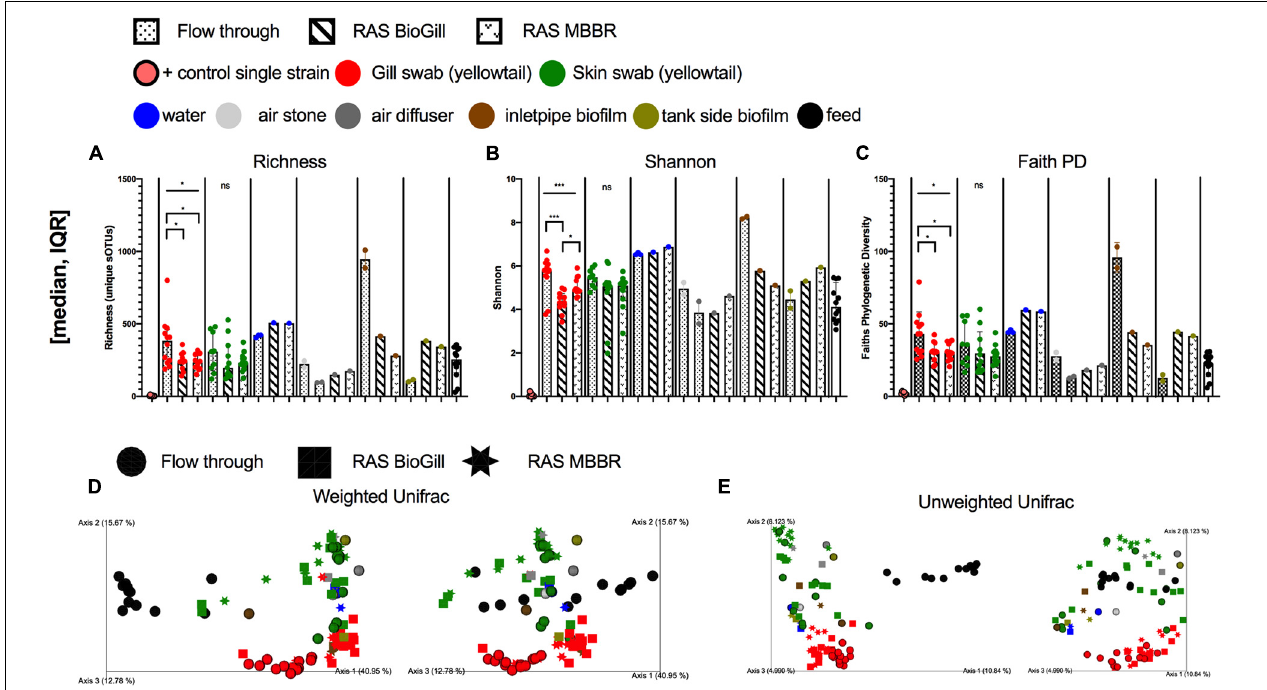
FIGURE 1 | Microbial diversity of the hatchery built environment along with fish gill and skin mucus at 130 days post hatch across three rearing tanks (flow through, RAS BioGill, and RAS MBBR). Alpha diversity as measured by (A) richness, (B) Shannon, and (C) Faith’s phylogenetic diversity. Gill and skin (group comparison calculated with Kruskal–Wallis test, Benjamini Hochberg FDR 0.05). Beta diversity calculated using (D) Weighted normalized UniFrac and (E) Unweighted UniFrac distance. (* P < 0.05, ** P < 0.01, *** P < 0.001, and **** P < 0.0001).